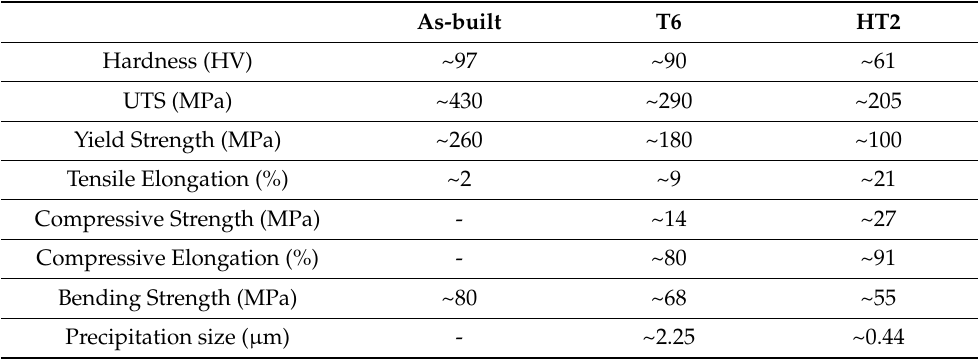
Table 3. Overview of mechanical properties in this study for as-built, T6 and HT2.